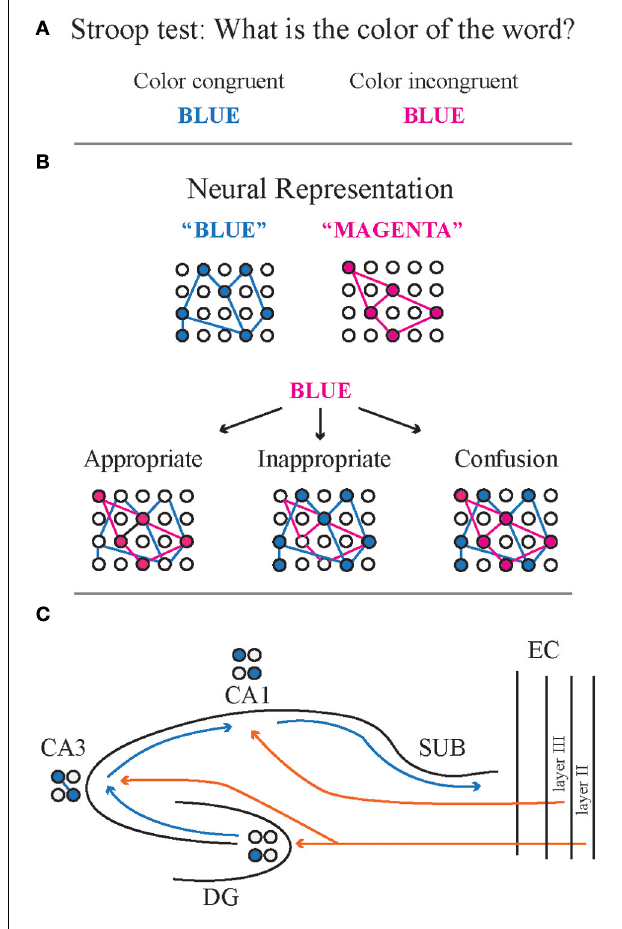
FIGURE 1 | Cognitive control depends on neural coordination, the coordinated activity of neural networks within or among brain regions. (A) During the Stroop test, the test subject is presented with a word that means a color. The word meaning and color match for color-meaning congruent words, whereas there is a mismatch for color incongruent words. (B) Neural representations are a coactive ensemble of neurons that coalesce into a temporally defined pattern to represent a concept. Neural coordination to express the appropriate representation is required for appropriate responds during the Stroop test. Coactivity implies that the neurons are functionally coupled to drive the emergence of the ensemble. The cognitive challenge is escalated for presentations of color incongruent words because the appropriate response requires suppression of the inappropriate neural representation, despite the presence of functional coupling to drive the neural representation for the word name. The appropriate response contrasts with the case of an inappropriate response to the color-incongruent word. Instead of the neural representation of the color, the inappropriate representation of the meaning emerges, suppressing the appropriate representation of the color. The neural equivalent of confusion results when both the color and meaning representations are simultaneously active, which is altogether a different inappropriate representation. (C) The hippocampus is a complex circuit in which multiple streams of information converge on a single area. For example, information from CA3 and entorhinal cortex must be coordinated in order to activate the appropriate response in CA1, a point of convergence for CA3 and EC activity. The dominant contemporary model asserts that the dentate gyrus mediates pattern separation because a few,